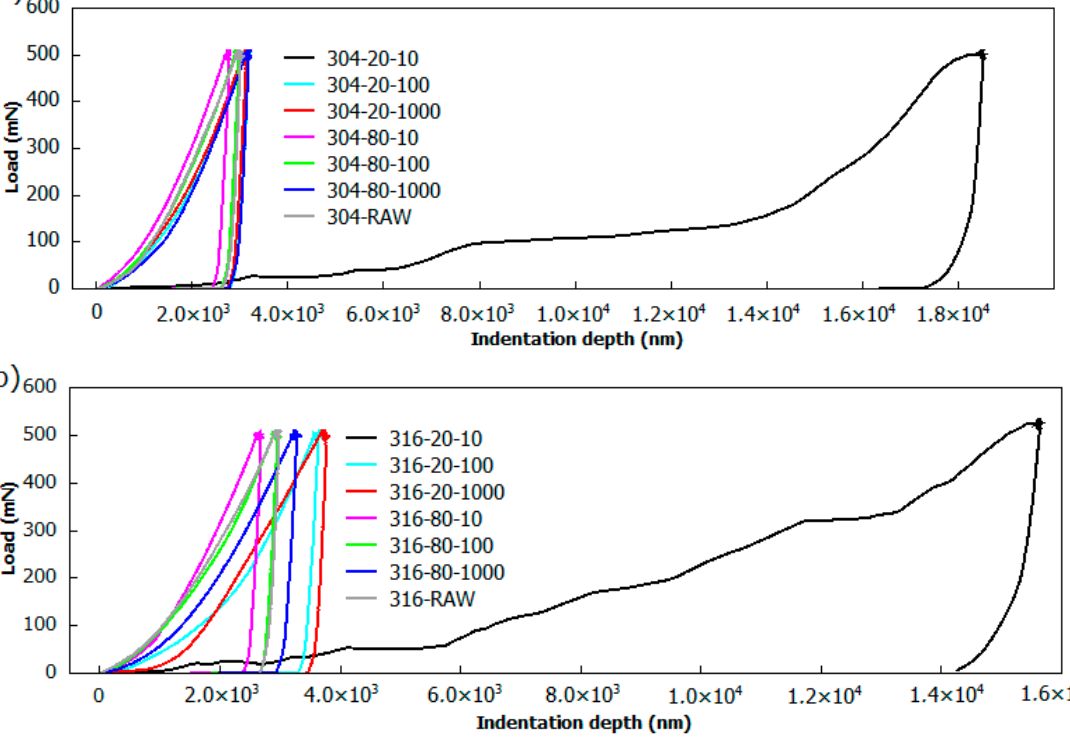
Figure 7. The load-displacement curve plots for: ( a ) AISI 304; and ( b ) AISI 316 stainless steel samples.